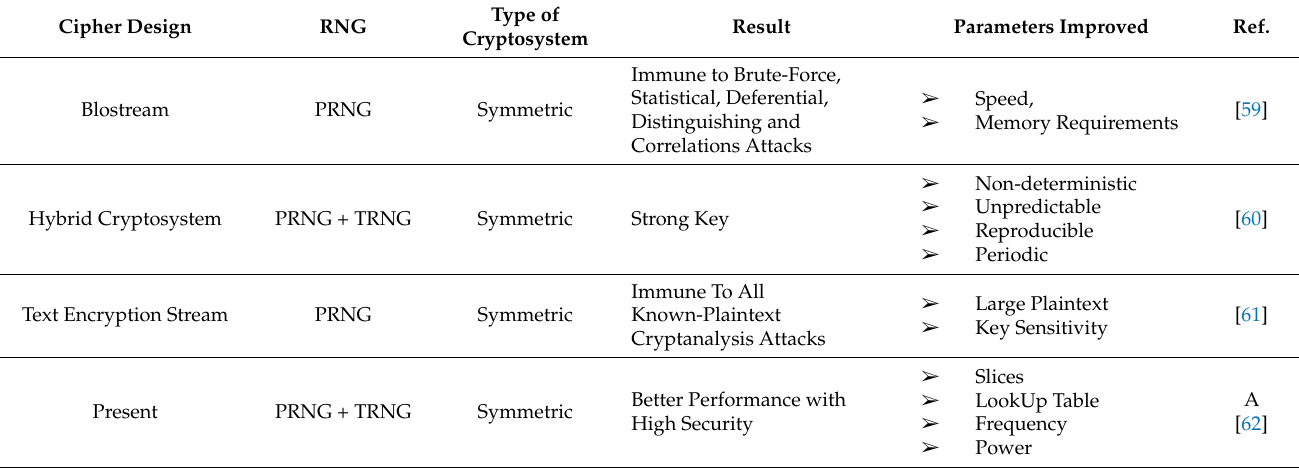
Table 4. Survey of RNG-based